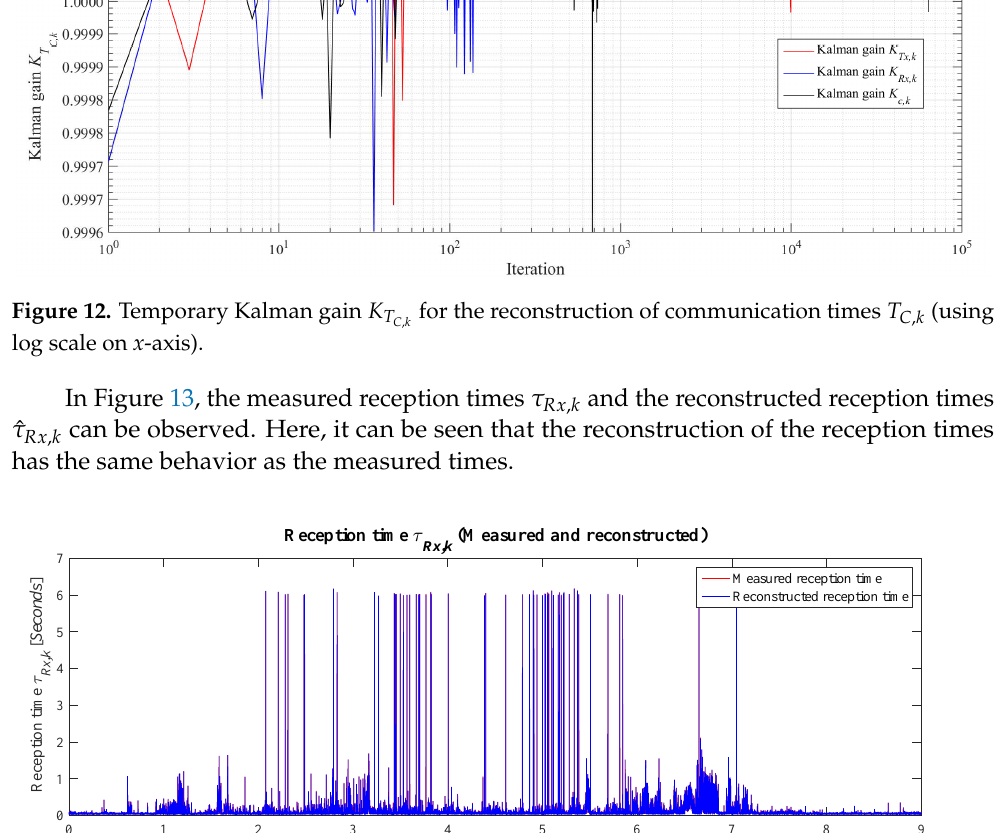
Figure 13. Comparison of reception times τ Rx , k measured and reconstructed.